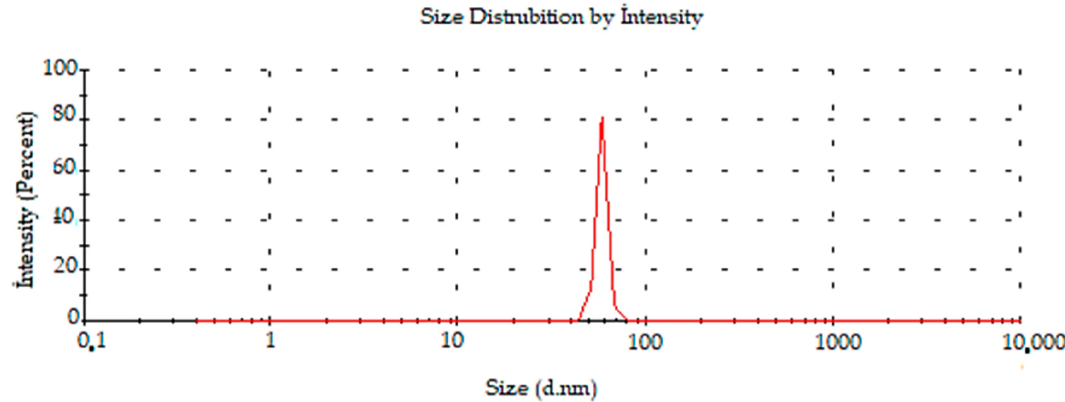
Figure 7. Zeta potential distribution of synthesized AC-AuNPs.